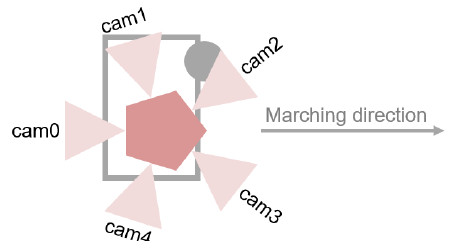
Figure 7. Top view of our backpack with camera head